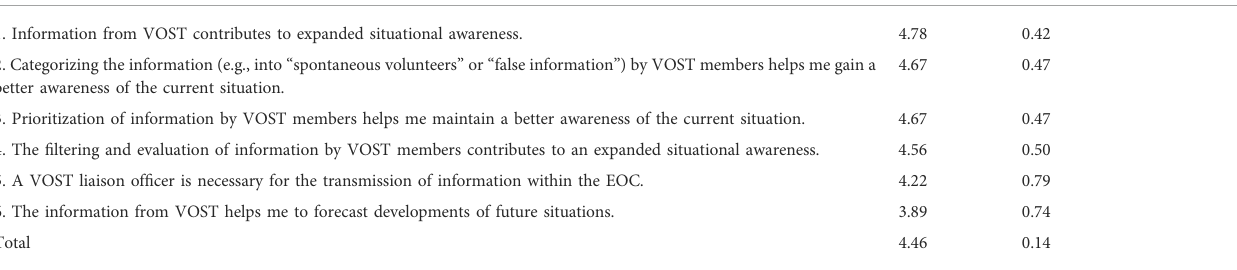
TABLE 4 VOST impact on situational awareness.